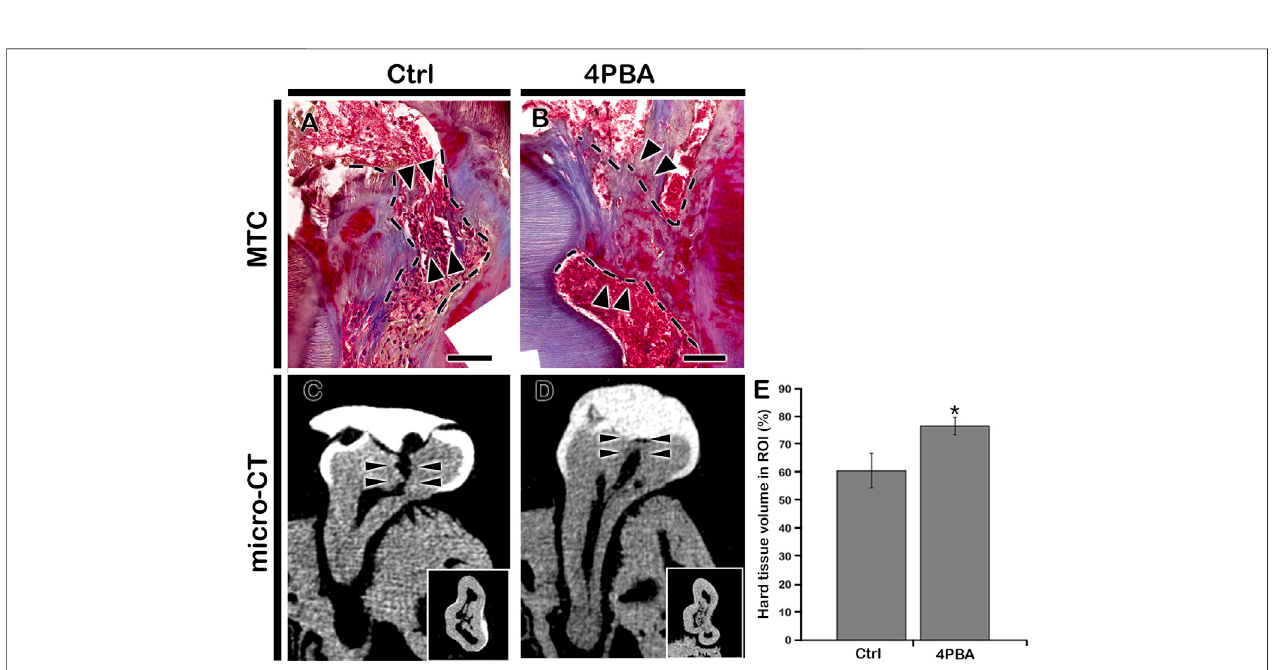
FIGURE 3 | Micro-CT examinations and MTC staining after 42 days from cavity preparation. MTC staining showing dentin-bridge (arrows) formation in the 4PBA- treated specimen (A – B) . Micro-CT showing pulpal access preparation and dentin-bridge formation after 42 days of cavity preparation (C – D) . The percentage of hard tissueformationwithintheregionofinterest(N=3) (E) .ROI,regionofinterest.InsetsinCandDindicateocclusalview.Arrowheadsindicateregionofinterestanddotted lines indicate formation of dentin bridge. * indicates p < 0.05 (E) . Scale bars: 50 μ m: A-B.